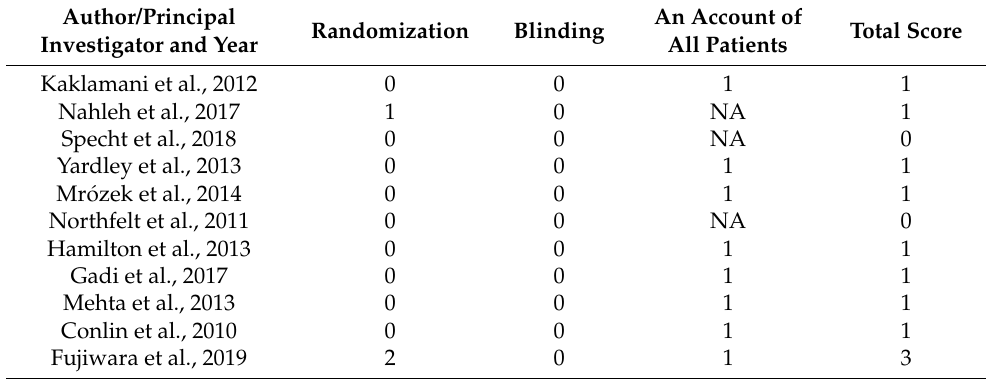
Table 4. Quality assessment of the reviewed studies using JADAD